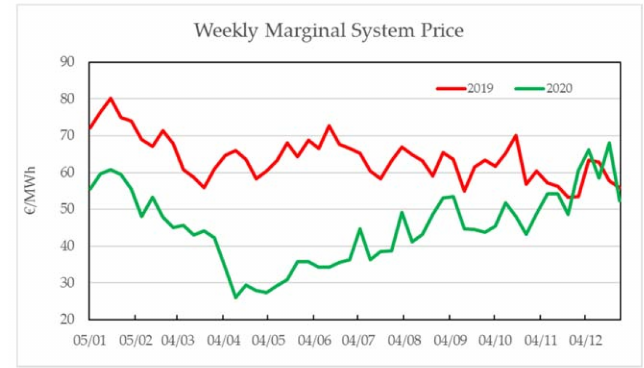
Figure 7. Weekly Marginal System Prices in 2019 and 2020 (in EUR/MWh).